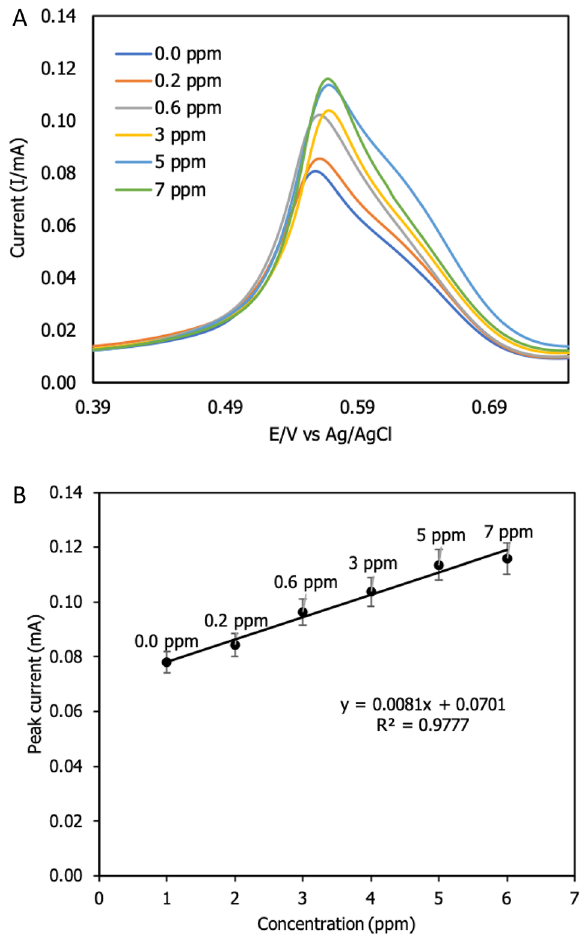
Figure 13. Effect of the different concentrations of Zn 2+ on modified electrode (f-MWCNTs/CS/PB/AuE): ( A ) DPV analysis of the different concentrations and ( B ) the linearity of the analyte concentration ( n = 3).